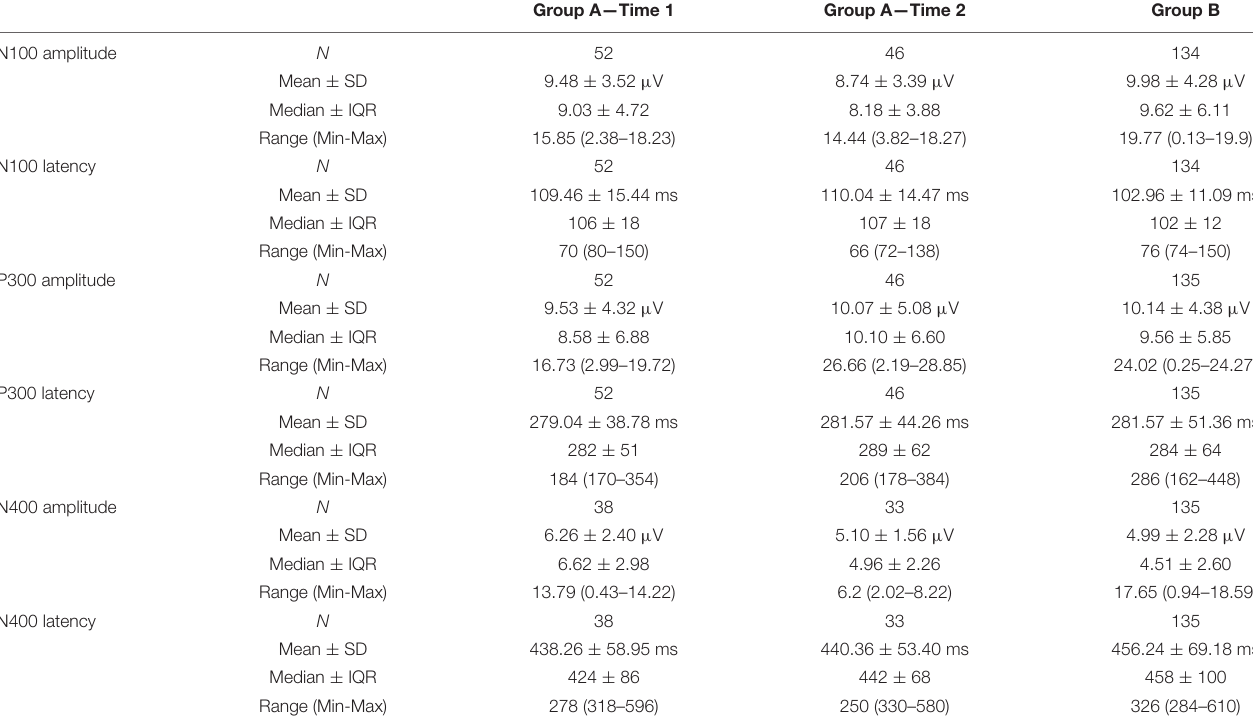
TABLE 2 | Descriptive statistics for all groups and time